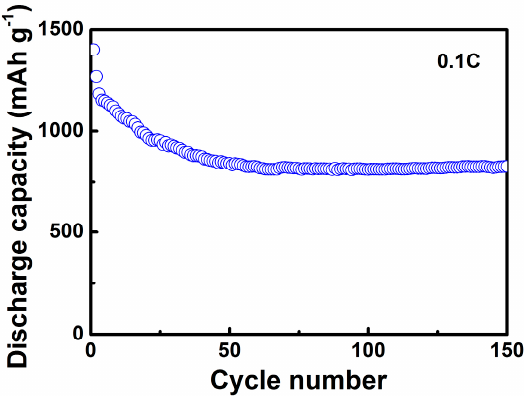
Figure 9. Cycling performance of the S/GO composite electrode at 0.1 C.